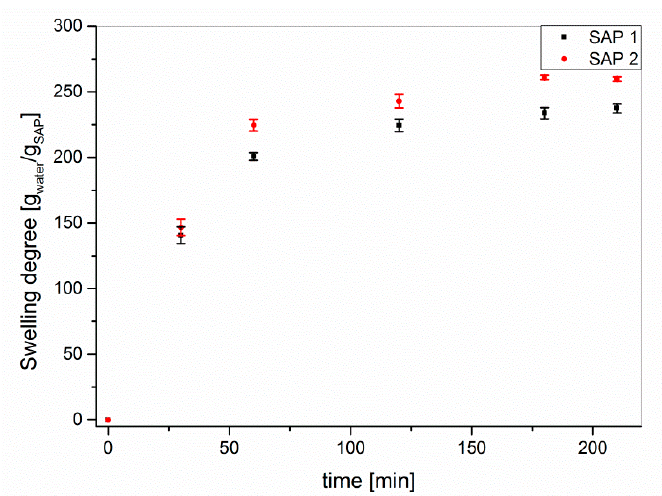
Figure 2. Time-dependent swelling of SAP 1 and SAP 2 as received in double-distilled water.